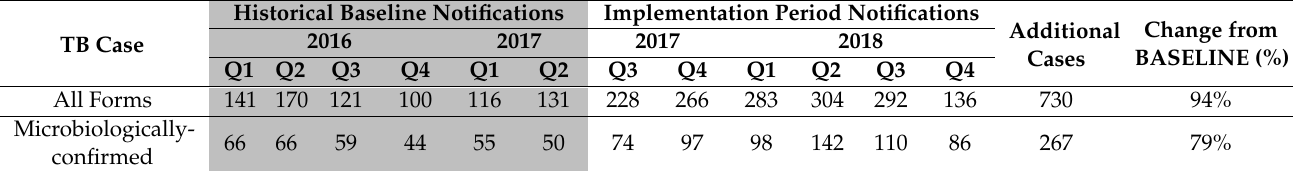
Table 2. Notifications in the National TB Elimination Program in the public project intervention area between January 2016 and December